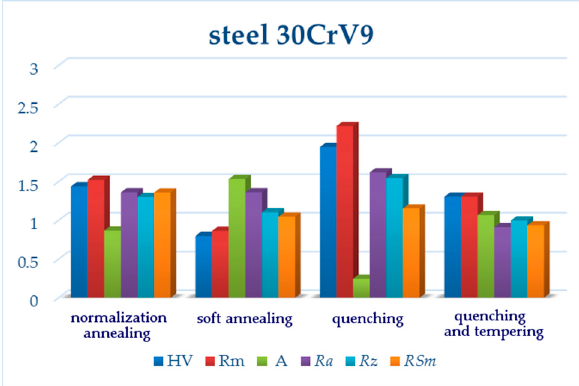
Figure 15. Relative changes of mechanical characteristics and measured surface roughness parameters for 30CrV9. All values were normalized, being divided by respective reference values (150 HV, 790 MPa, 15%; Ra , Rz, RSm values for the upper line of the normalization annealing sample).